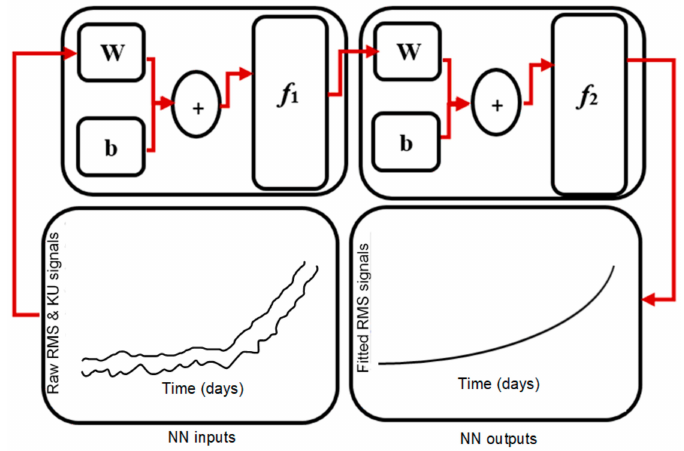
Figure 8. Neural network training